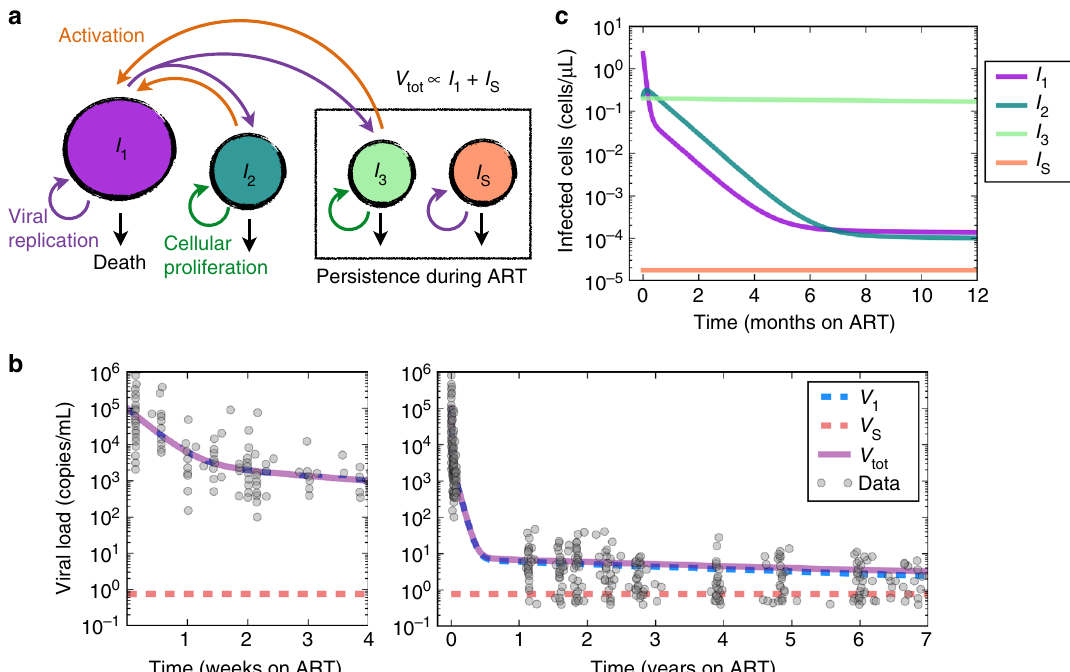
Fig. 6 Mechanistic modeling of HIV RNA decay during ART. a Model schematic: I 1 cells produce virus, pre-integration latent cells I 2 are longer lived and transition to I 1 , and long-lived latently infected cells I 3( j ) proliferate and die at measured rates depending on cell phenotype j (e.g., effector memory, central memory, naive). Sanctuary cells I S allow ongoing HIV replication despite ART. Parameters and their values are discussed in the Methods and listed in Table 1. b The mathematical model recapitulates observed HIV RNA data 51 over weeks and years of ART. V 1 is virus derived from I 1 while V S is derived from I I I S . c 3 becomes the predominant infected cell state early during ART. S is constrained to be very small to explain the lack of detectable viremia on fully suppressive ART. Lines are colored to match schematic in a